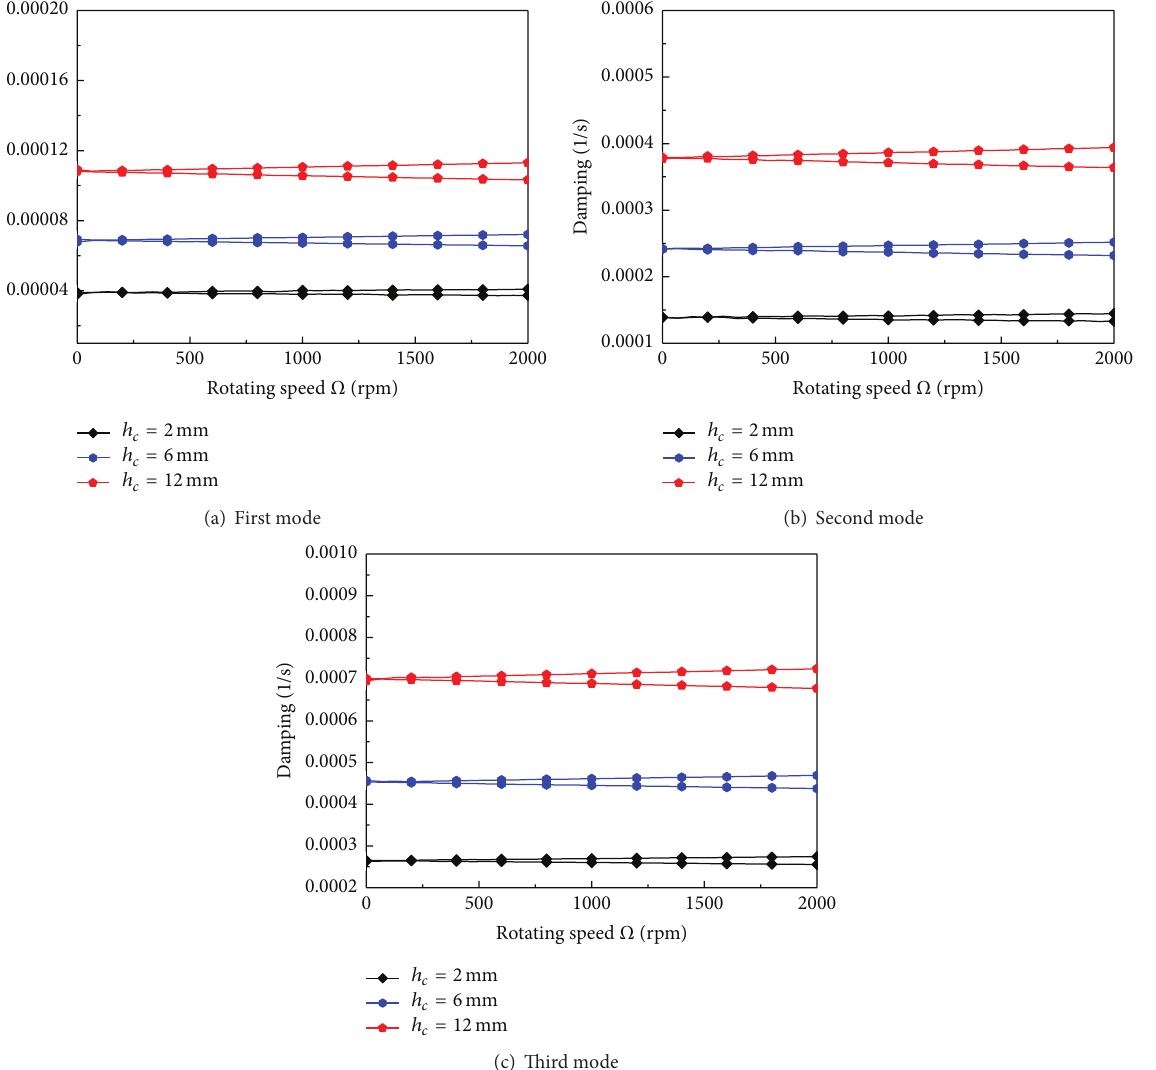
Figure 7: The first three dampings versus rotating speed for various thicknesses of constraining layer ( ℎ V = 2 mm, 𝜃 = 60 ∘ ).